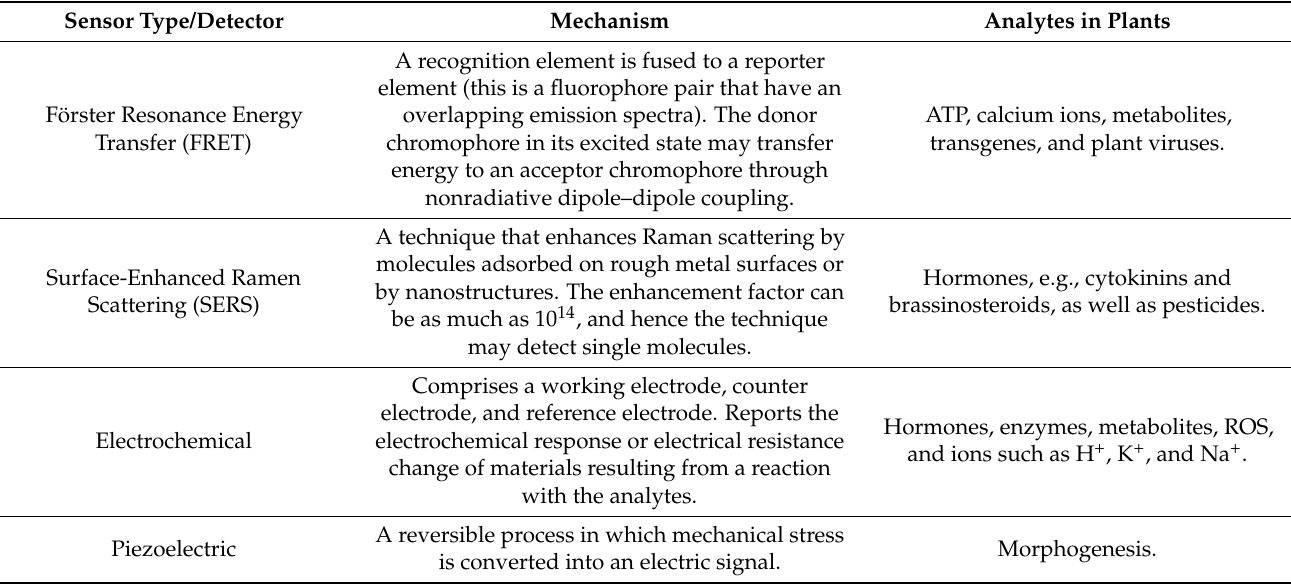
Table 1. Nanosensors, their mechanism of action, and example analytes in